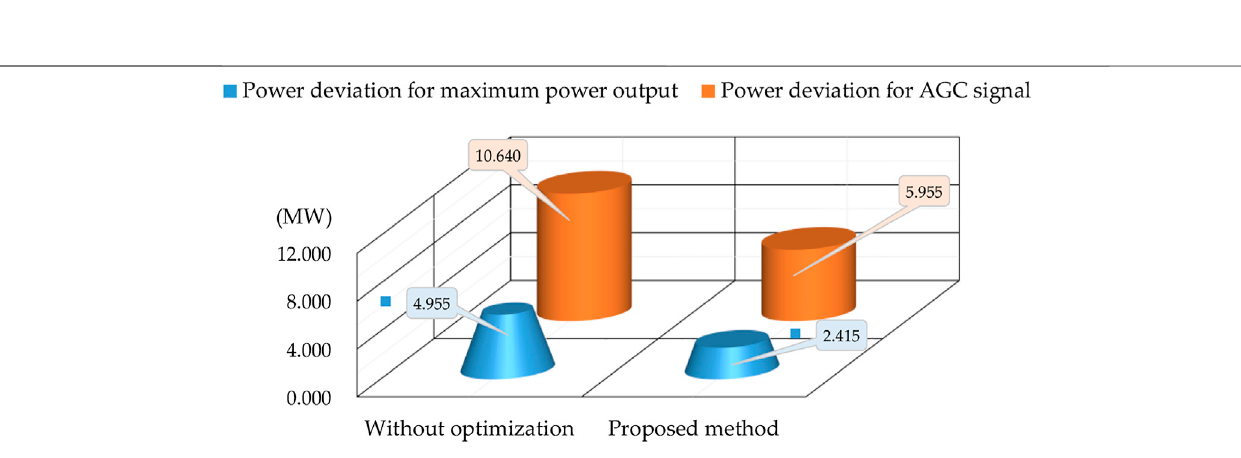
FIGURE 9 | Result comparison between proposed method and that without optimization on a constant AGC signal.